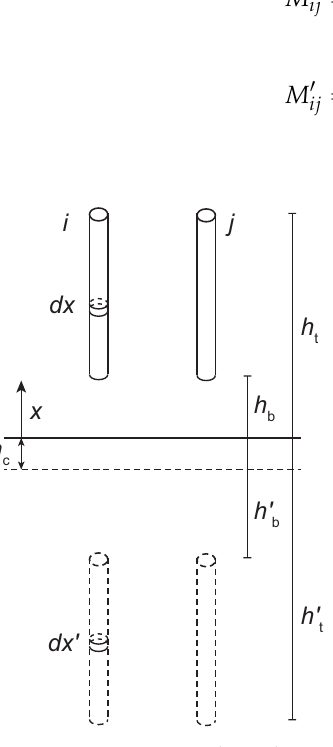
Figure 10. Two vertical conductors (approximating two legs of the tower) extending from h = h b to h = h t over the soil; the finite conductivity of the soil is accounted for through an equivalent configuration, which includes the conductors’ images with respect to an auxiliary plane at reference potential, placed at complex depth h c below the soil-air